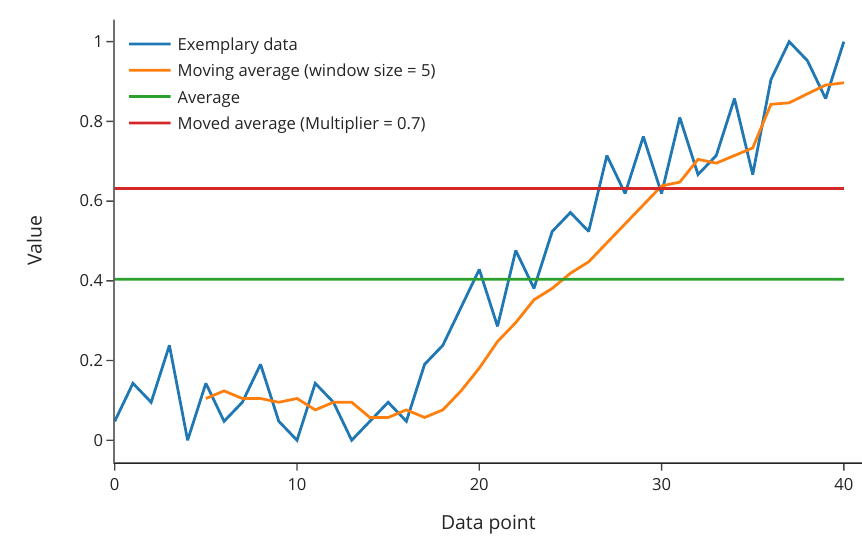
Figure 1. Example for the trend detection method using moving